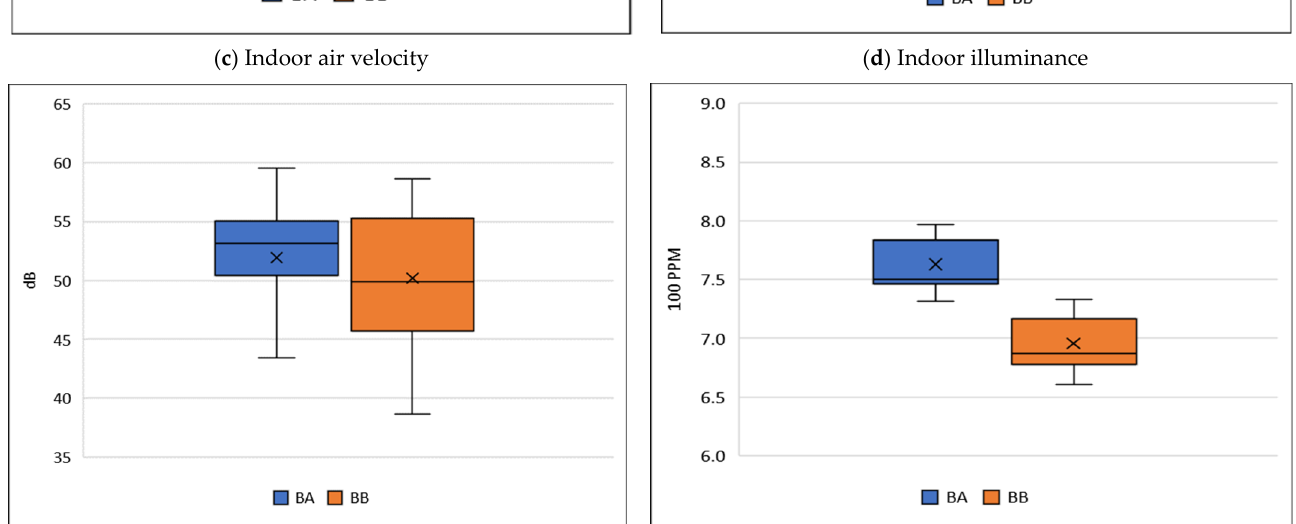
near the window to reduce the intensity of daylight. However, this action resulted in dim spaces within a range from the window, in which occupants suffered from low-level day- light and luminance level. To diminish this issue, occupants were provided with task lighting in building B and an atrium is applied in the design of building A. Particularly, task lighting significantly enhances the individual’s visual quality, although the indoor environment is dim. This is supported by the illuminance level being very low, although the occupants reported overall comfort from light quality in building B. In addition to the distance of the window within the inner part of the building, the daylight was trapped by workspaces with high-level partitions before reaching the inner workspaces, resulting in dim spaces for inner parts. Regarding background noise from outdoors, buildings were located near the street. Additionally, the neighbourhood buildings and transportation density are observed to be lower for building B. However, the study buildings are fully air-conditioned with no op- erable windows, which significantly reduces noise penetration. SPL is similar for both buildings and ranges from 43.45 to 59.55 dB, with a mean of 51.9 dB, and 38.65 to 58.65, with a mean of 50.2 dB, for buildings A and B, respectively (Figure 3e). Mui and Wong [64] reported that the neutral SPL for aural comfort in typical air-conditioned offices should be between 45 and 70 dB, with a mean of 57.5 dB. Mean CO 2 was detected to be 763 and 695 ppm for buildings A and B, respectively (Figure 3f). CO 2 lower than 1000 ppm is considered harmless [65]. No vestige of TVOC was detected in both buildings, with 0 ppm measured. A similar AC management scheme is applied to both buildings A and B. This scheme activates AC only during operation hours of the office building (8 a.m. to 6 p.m.). Besides, the buildings mainly included open-plan office workstations as well as a few private rooms, conference rooms, and storage spaces. Given the typical office work of the occupants, such as sedentary activities, there are no significant indoor heat gains from occupants’ activities. Personal fans were observed